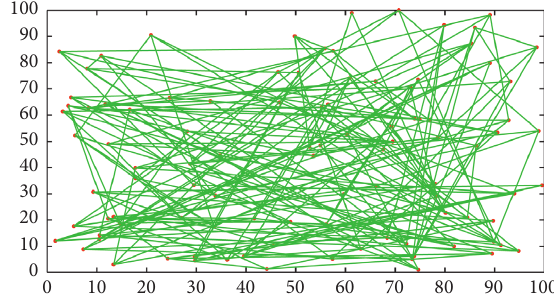
Figure 2: Network structure is displayed when connection probability p � 0 . 05.